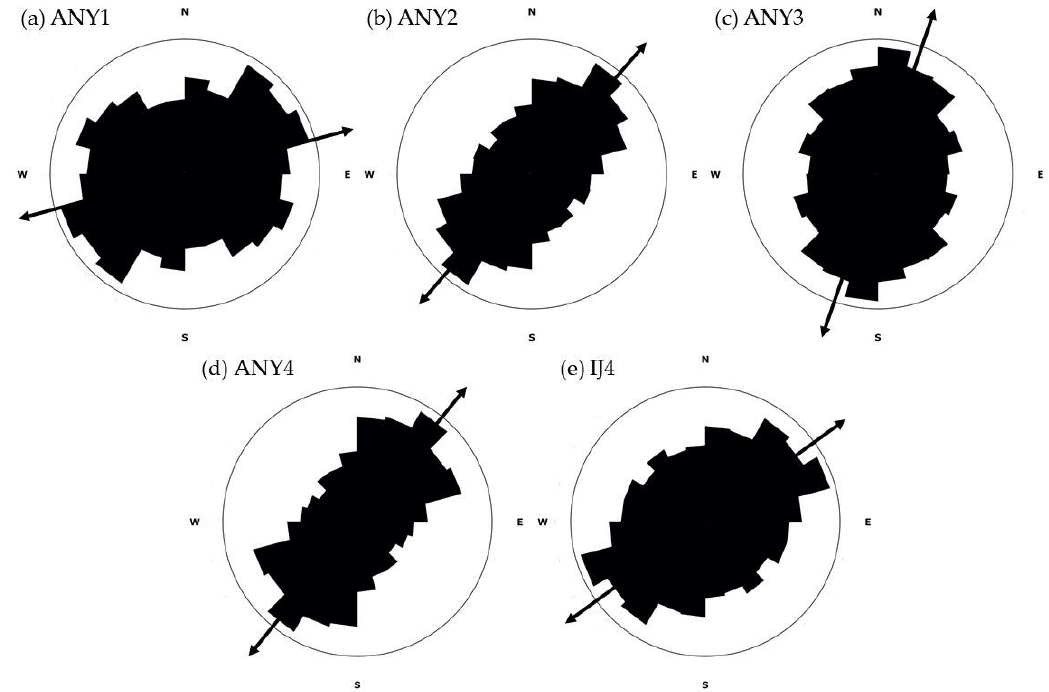
Figure 5. Rose diagrams of horizontal slices of ( a ) ANY1; ( b ) ANY2; ( c ) ANY3; ( d ) ANY4 and ( e ) IJ4 specimens that were used in μCT imaging. These diagrams show the distribution of the declination of pores orientation. Vertical axis represents North-South direction while horizontal axis represents East-West direction. Black arrows indicate the declination preferred pore orientation.